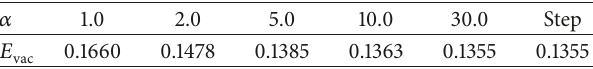
Table 3: VPE for background potential 𝑉 훼 (𝑥) defined in the main text. The entry “ step ” gives the VPE for the step function potential 𝑉(𝑥) = 3Θ(𝑥) using (23) and its Born approximation from (27) for 𝑥 = 0 . 푚